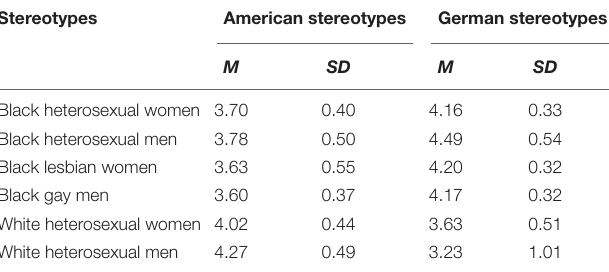
TABLE 2 | Agreement with American and German